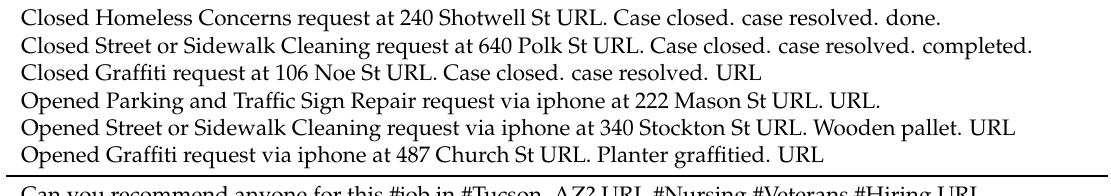
Table 1. Examples of tweets from accounts which posted more than 150 tweets in a day. They are used as examples of tweets from bot accounts. ’URL’ represents a link contained in the tweet. Closed Homeless Concerns request at 240 Shotwell St URL. Case closed. case resolved.